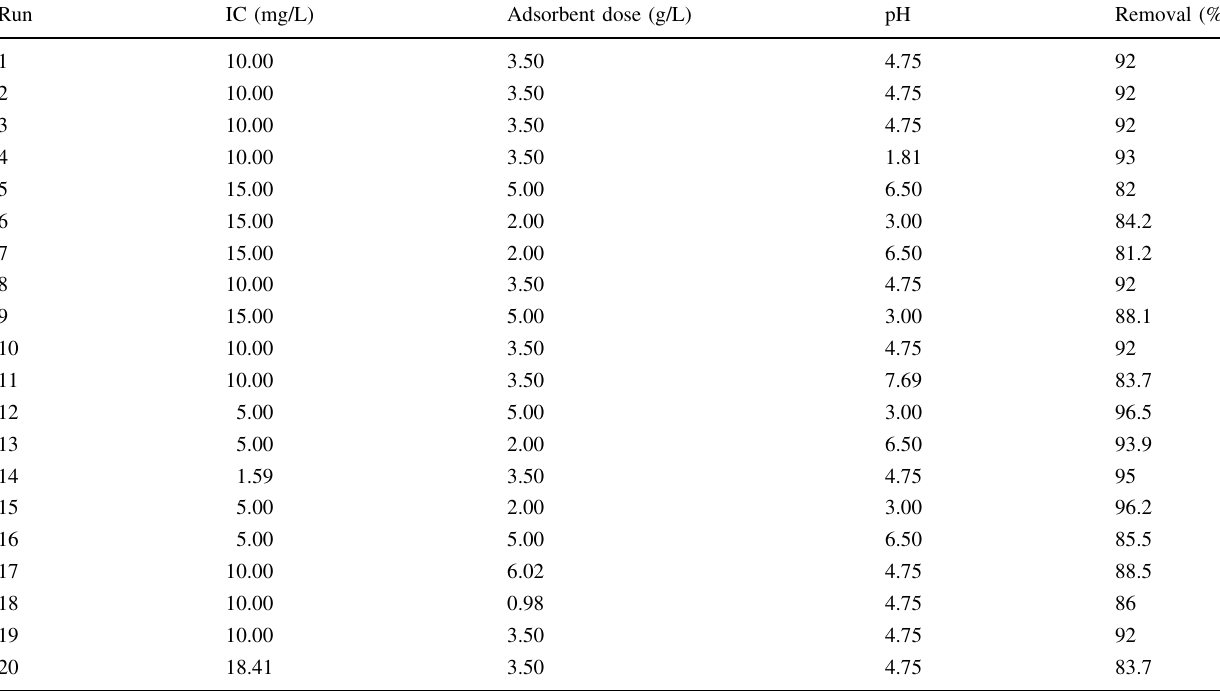
Table 9 Experimental design and response to optimize fluoride removal